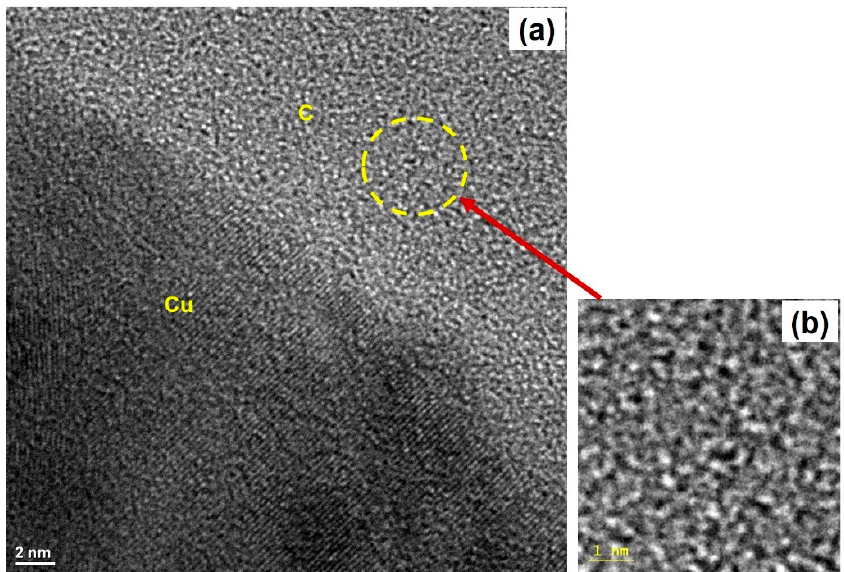
Figure A6. ( a ) High-resolution cross-sectional TEM image of the carbon film on a flat smooth surface of the same copper foil substrate, showing a homogenous amorphous carbon film without any nanolayered structures on the interface or anywhere else; ( b ) an enlarged view of the film. Scale bar in ( a ): 2 nm; scale bar in ( b ): 1 nm.